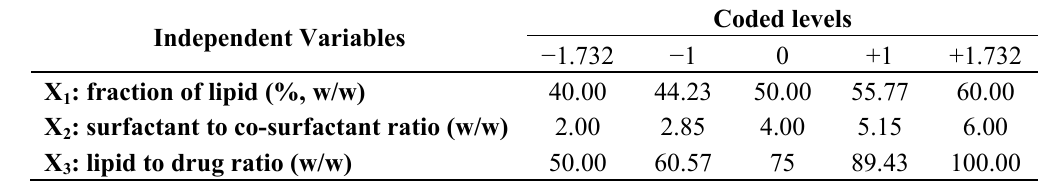
Table 3. Independent variables and their levels of